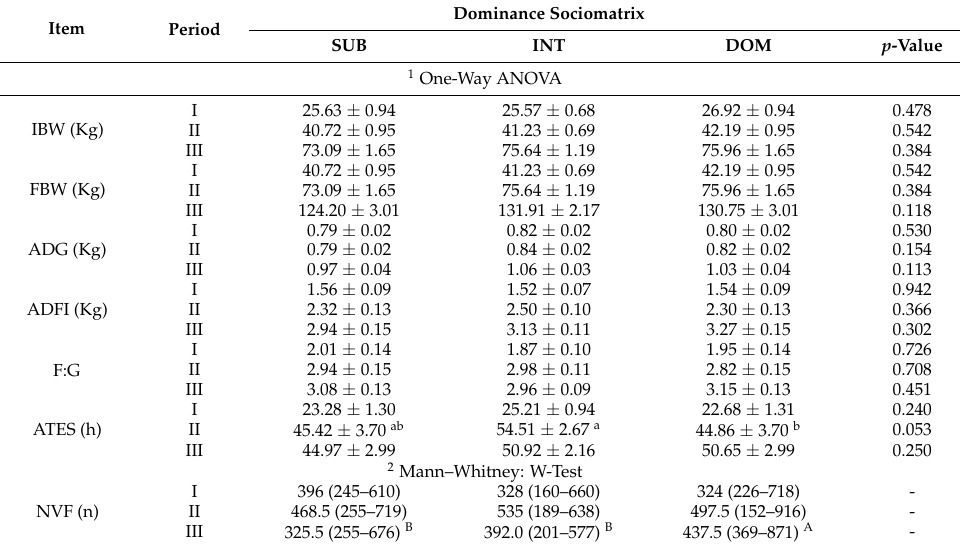
Table 5. Data of performance (mean ± SE) and feeding behavior (median, min–max) of growing and finishing pigs according to dominance sociomatrix classification and period of